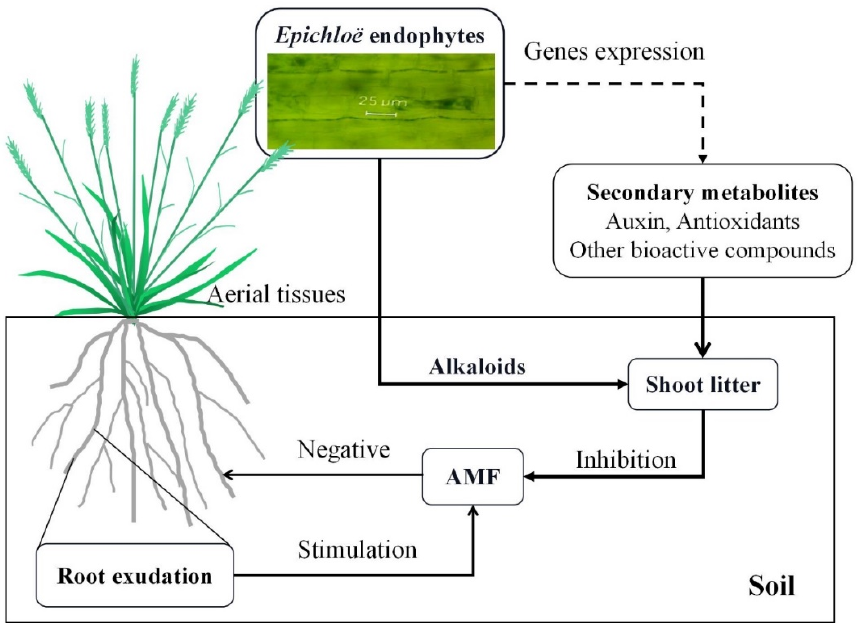
Figure 3. The synthesis of potential mechanisms for the effects of Epichloë endophytes infection/presence on the developmental processes of grass roots and soil arbuscular mycorrhizal fungi (AMF).